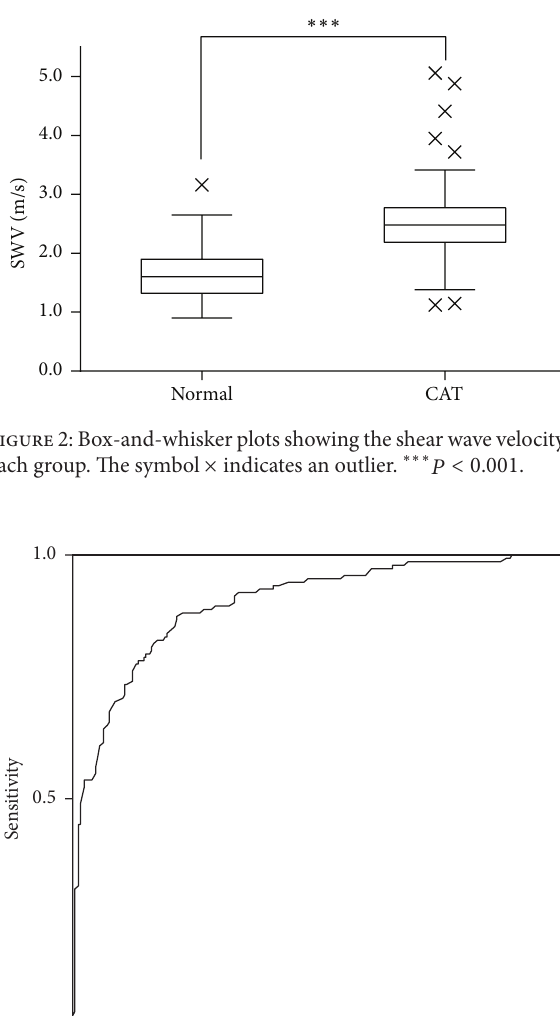
Figure 5: Correlation between shear wave velocity and thyroid isthmus